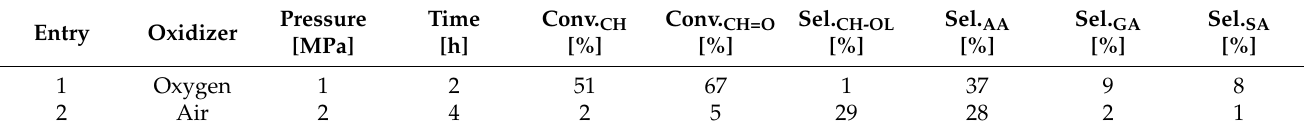
Table 5. Effect of the oxidizing agent on CH/CH=O mixture